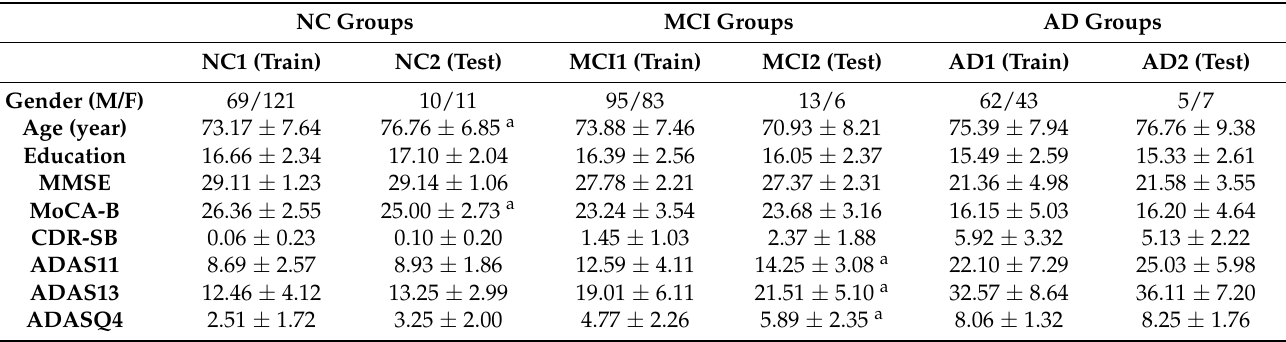
Table 1. Demographic information in this study.